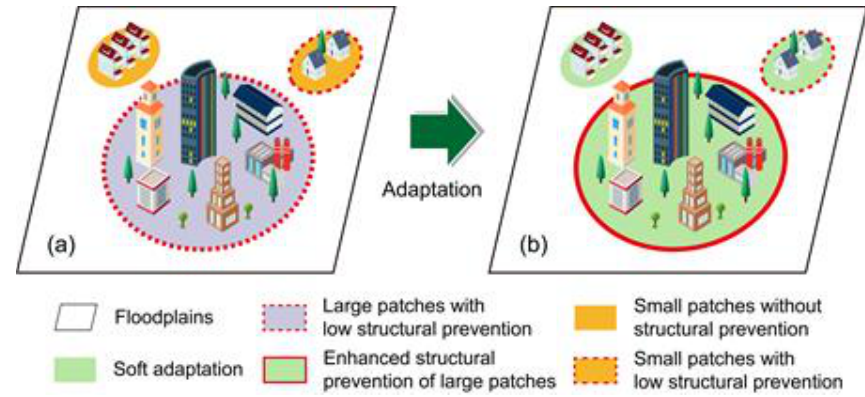
Figure 14. Flood adaptation strategies between different patch sizes in floodplains. ( a ) indicates the Figure 15. Flood adaptation strategies between di ff erent patch sizes in floodplains. ( a ) indicates the current situation of flood prevention for different patch sizes. ( b ) shows their corresponding flood current situation of flood prevention for di ff erent patch sizes. ( b ) shows their corresponding flood adaptation measures. adaptation